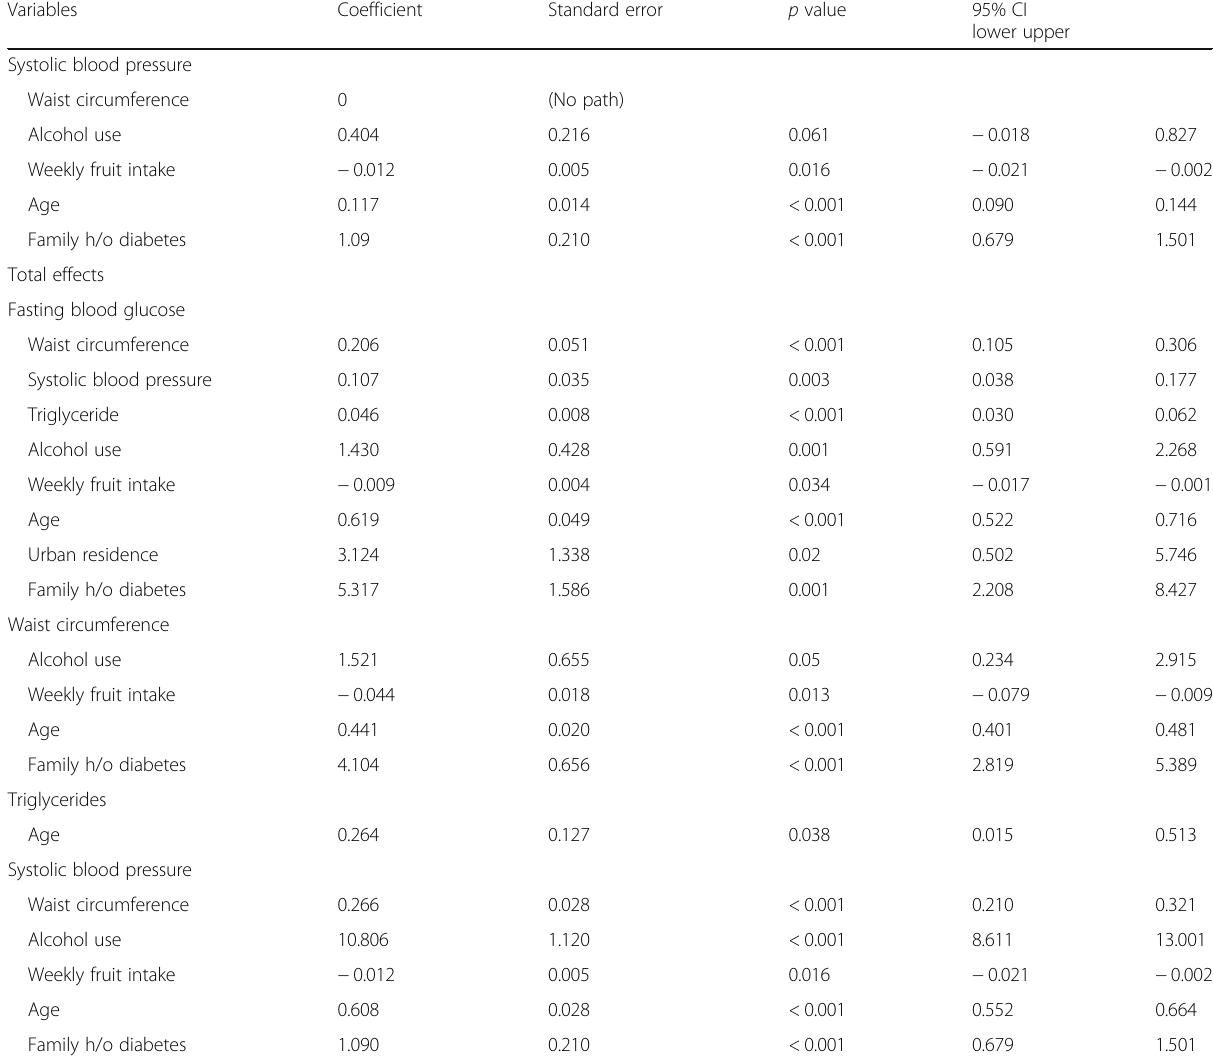
Table 2 Coefficient and standard error of the final SEM model of risk factors for diabetes in the STEPwise approach to surveillance 2015 survey — Punjab, India among adults aged 18 – 69 years (Continued)